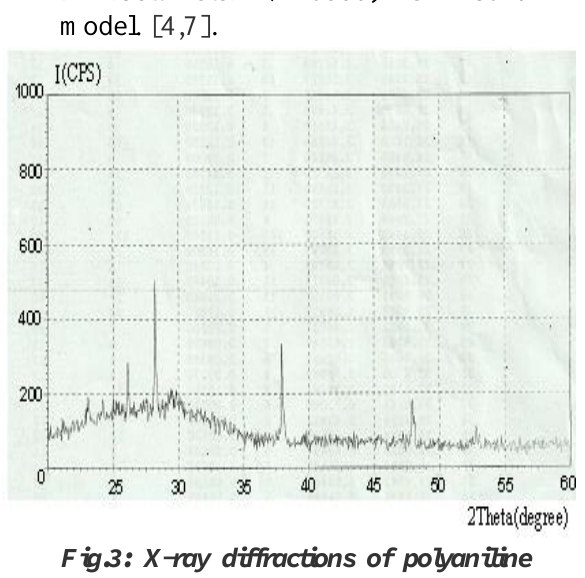
Fig.3: X-ray diffractions of polyaniline thin